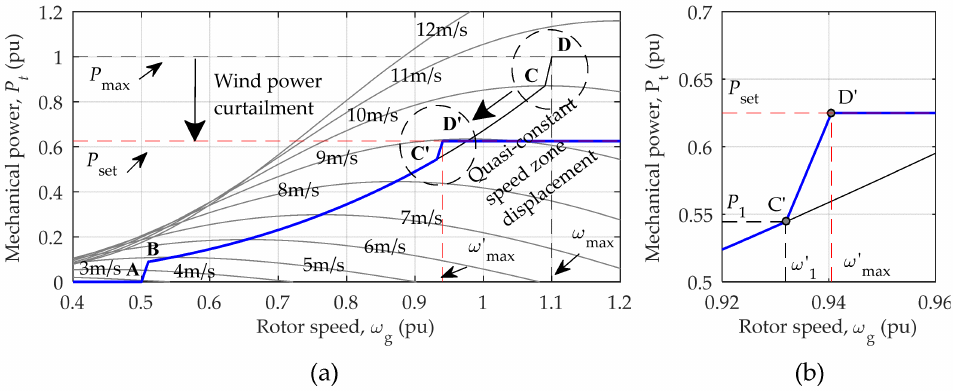
Figure 16. Active power curtailment procedure: ( a ) MPPT curve clipping; ( b ) Quasi-constant speed zone under curtailed